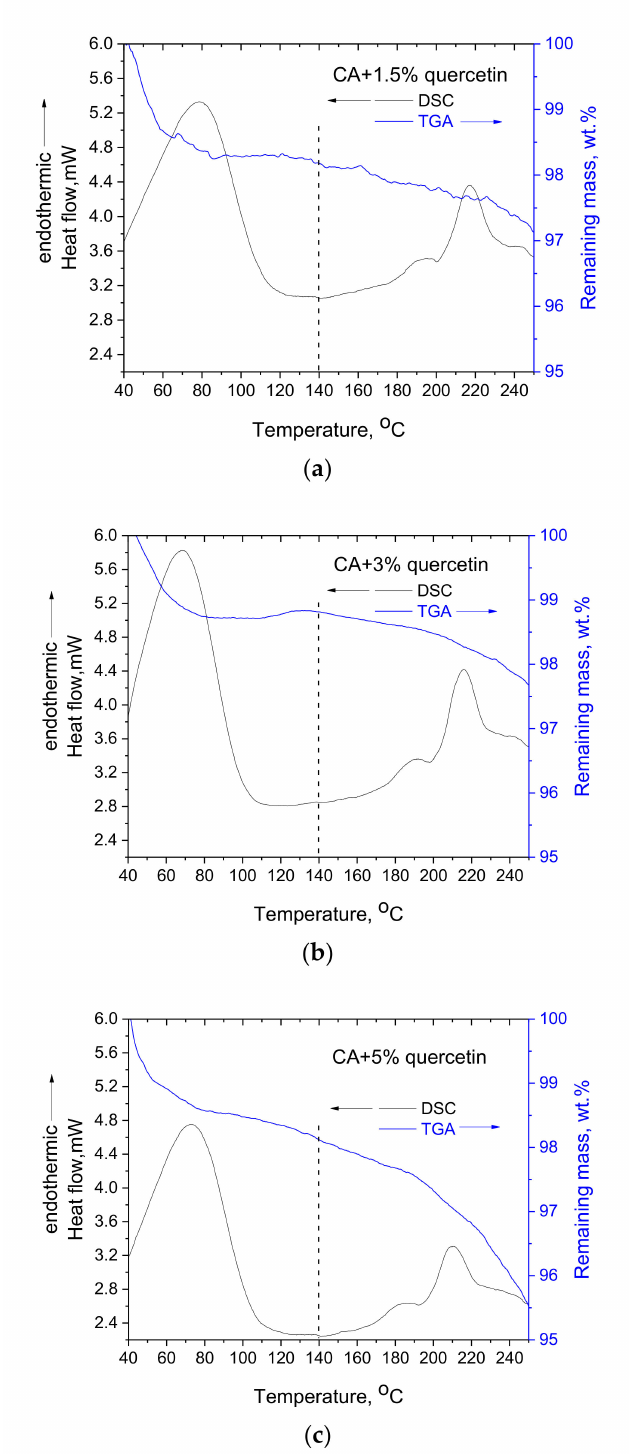
Figure 4. DSC and TGA curves of CA-quercetin composite membranes with quercetin loadings of 1.5 wt.% ( a ), 3 wt.% ( b ) and 5 wt.% ( c